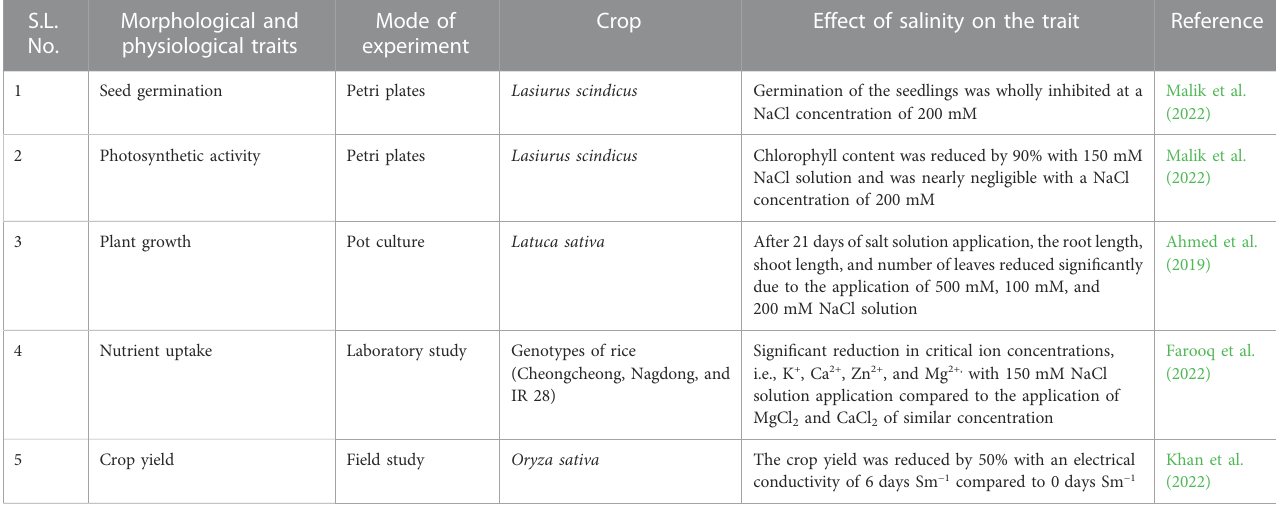
TABLE 2 Effect of salinity on various physiological and morphological traits affecting crop yield. S.L.